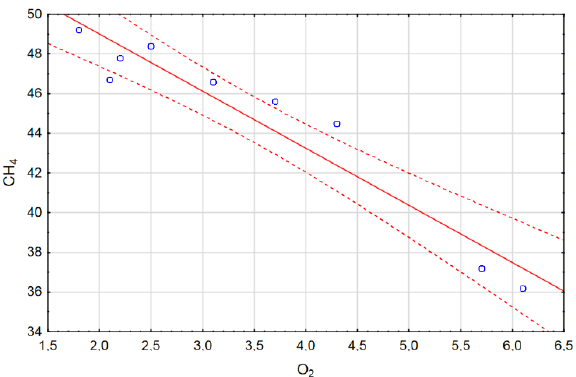
Figure 3. Scatterplot of the CH 4 and O 2 correlation.